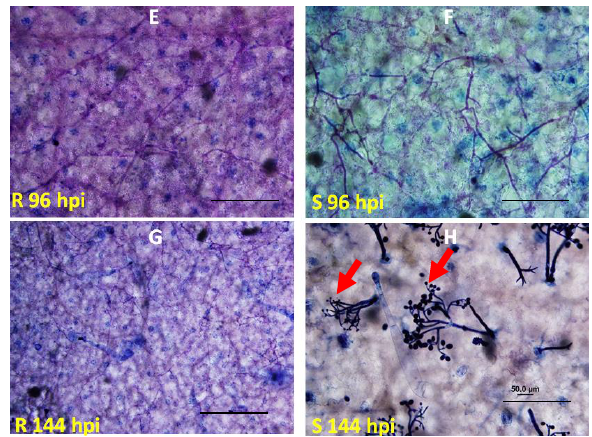
Figure 1. Histological analyses to TKF 4321 and TKF 2002 leaves inoculated with blue mold pathogen. The progress of tissue colonization by the pathogen is shown in panels A, C, E, G in the resistant parental line TKF 4321, and in B, D, F, H for the susceptible line TKF 2002. Hyphae were stained with trypan blue and observations were performed at 48 hpi ( A , B ); 72 hpi ( C , D ), 96 hpi ( E , F ), and 144 hpi ( G , H ). The life cycle of P. tabacina can be quickly completed on TKF 2002 plants within six days post inoculation, but the spread of pathogen is seriously hampered on TKF 4321 plants with restricted growth of hyphae. The yellow arrows in 1B and 1C indicate hyphae at the early stage of infection. The red arrows in 1H indicate sporangiophores. R, resistant; S, susceptible; hpi, hours